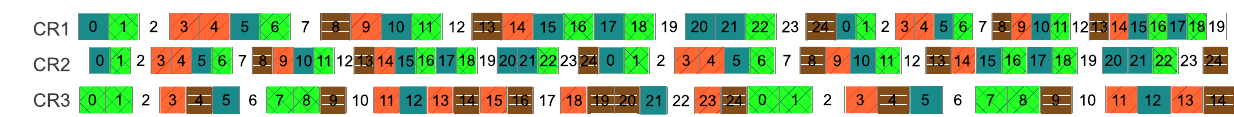
Figure 6. Example of the random cycle duration with three CR nodes, with 5 unoccupied channels, using the optimized RAC 2 E-gQS protocol: CR1 and CR2 have the same channel order, CR3 has an opposite channel order.